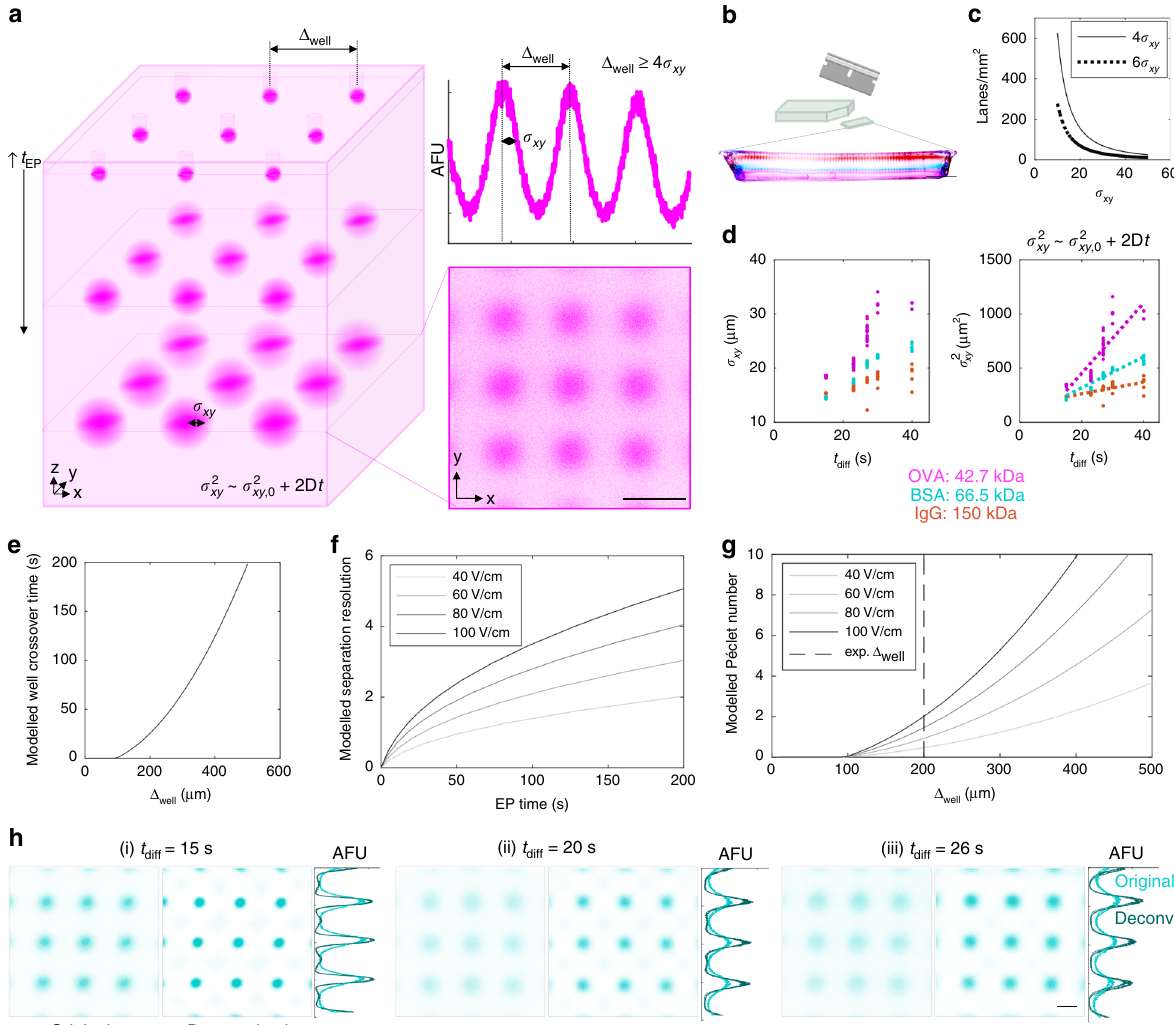
Fig. 3 The physics of 3D diffusion dictate projection electrophoresis device design and inform image analyses. ( a ) Lane density (limited by minimum spacing between separation lanes Δ well ) is dependent on separated protein xy bandwidth ( σ xy ) to avoid microwell-microwell crosstalk. σ xy in turn depends on 3D diffusion of the injected protein. Simulated data shown in the left schematic; measured OVA data shown in micrograph and intensity pro fi le (representative of two independent separation gels). Scale bar represents 100 μ m. ( b ) Throughput is a function of both lane density and usable gel area; separated protein bands parallel to the gel edges in a cross-sectional image of the gel show uniform migration across the gel. Scale bar represents 1 mm. ( c ) Theoretical maximum lane density at a spacing of 4 σ xy (~5% overlap between lanes) and 6 σ xy (~0.3% overlap between lanes). Maximum lane density is inversely proportional to σ xy 2 . ( d ) Measured diffusional xy band broadening (Gaussian fi t peak width σ xy ) from puri fi ed proteins initially partitioned into 32 μ m microwells, as a function of in-gel diffusion time ( t diff ). Left: σ xy vs. t diff . Right: σ xy 2 vs. t diff with linear fi ts ( σ xy 2 = σ xy,0 2 + 2Dt diff ). After 10 s EP, we measure σ xy < 30 μ m for all proteins, suggesting that 200 μ m microwell spacing is suf fi cient. Linear fi tting yields OVA σ xy 2 = 32.5 t diff -198 ( R 2 = 0.75); BSA σ + 29.8 ( R 2 = 0.88); IgG σ + 153 ( R 2 = 0.42). ( e ) Modeled time for ovalbumin bands to diffuse into the neighboring lane, as a 2 = 14.3 t 2 = 5.41 t xy diff xy diff function of microwell spacing Δ well . ( f ) Modeled separation resolution for BSA and OVA, as a function of EP time and electric fi eld strength. ( g ) Modeled Péclet number (de fi ned as the ratio of the time to reach a BSA-OVA separation resolution of 1 to the time at which the OVA band is expected to diffuse into the neighboring separation lane). ( h ) Physics-driven postprocessing. For each confocal slice (BSA, 7%T gel), the original image, that after physics- driven postprocessing (deconvolution of a point spread function modeling 3D diffusion), and summed pre- and post-deconvolution intensity pro fi les for a 100 μ m region surrounding each row of protein bands are shown. Each image pair is scaled to the maximum of the (higher-intensity) deconvolved image. Scale bar represents 50 μ m. Source data are provided as a Source Data fi is the electric fi eld, and D 1 and D 2 are the diffusion coef fi cients p(cid:3) (cid:4) ; ffiffiffiffiffiffiffiffiffiffiffiffiffiffiffiffiffiffiffiffi p ffiffiffiffiffiffiffiffiffiffiffiffiffiffiffiffiffiffiffiffi ð 2 Þ σ 2 þ 2 D þ 4 σ 2 þ 2 D t t 1 2 0 0 where Δ z is the difference in migration distance between the two protein targets, σ 1 and σ 2 are the z -direction peak widths, Δμ EP is the difference in electrophoretic mobility between the two targets, E